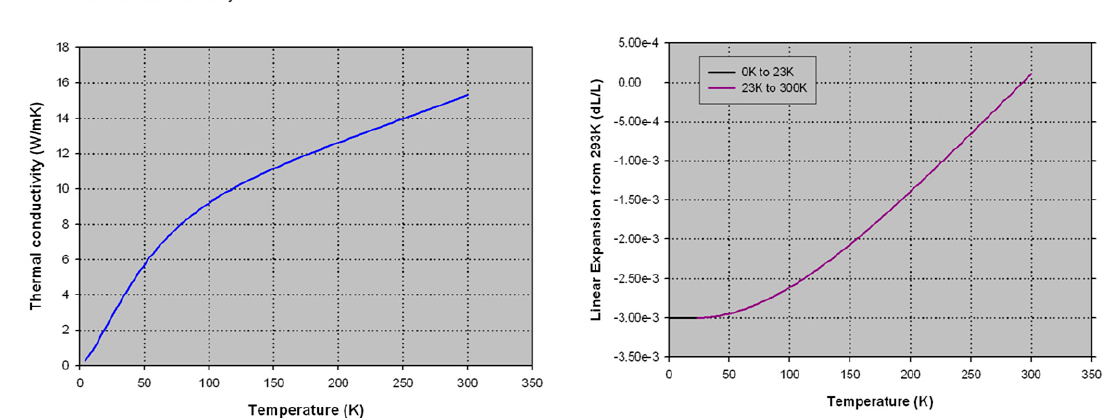
Figure 3. Variation in the thermal conductivity and linear expansion of stainless steel 304 [11].